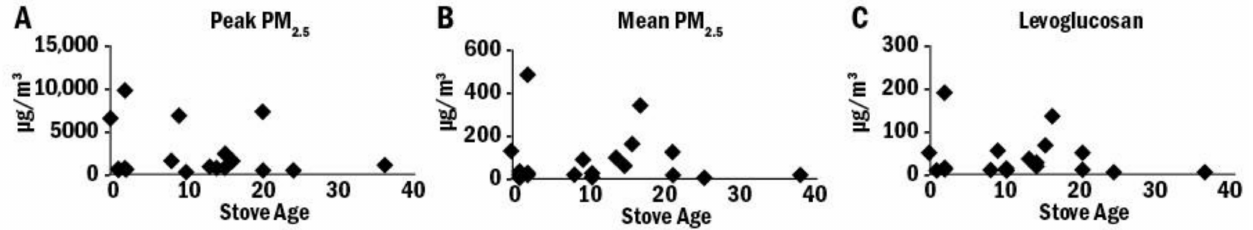
Figure 4. Age of the wood stoves was not correlated with PM 2.5 or levoglucosan. Neither Peak ( A ) nor mean ( B ) of PM 2.5 emission was associated with the age of the wood stoves. Similarly, the level of levoglucosan was not associated with the age of the stoves ( C